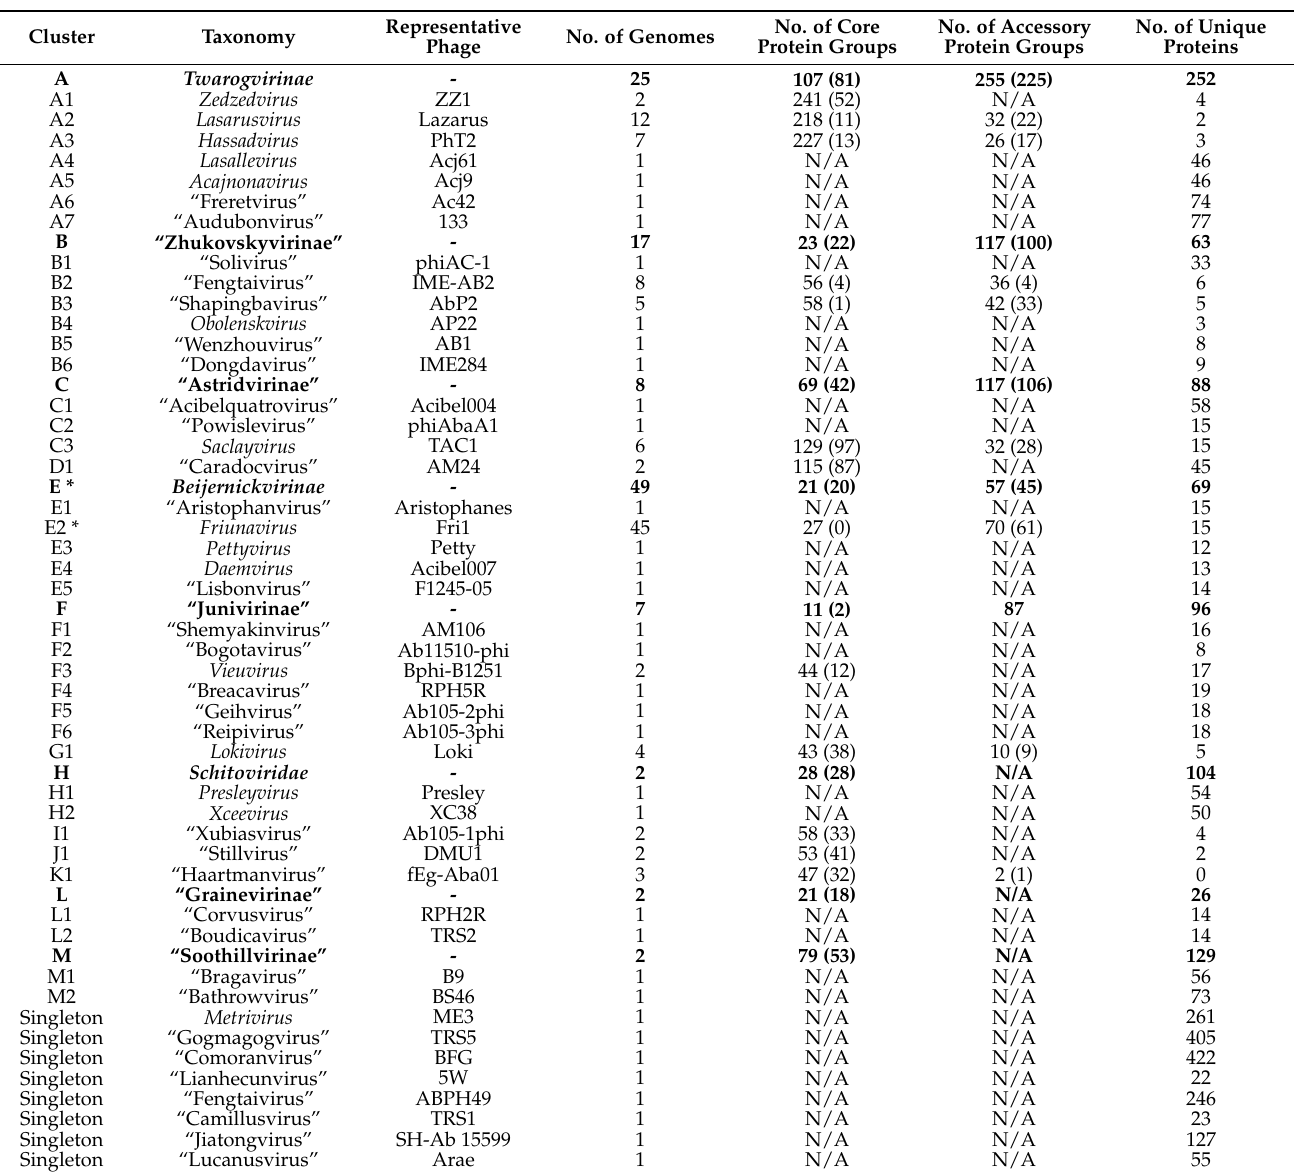
Table 1. Diversity of Acinetobacter phage genomes, composed of 8 clusters, 38 sub-clusters, and 8 singletons. Core, accessory, and unique protein groups identified within each cluster and sub- cluster are presented. Clusters corresponding to subfamilies are presented in bold type. Numbers in parentheses refer to protein groups found exclusively within the designated cluster. Ratified ICTV taxa are presented in italics, while proposed subfamily and genus names are presented as roman text within